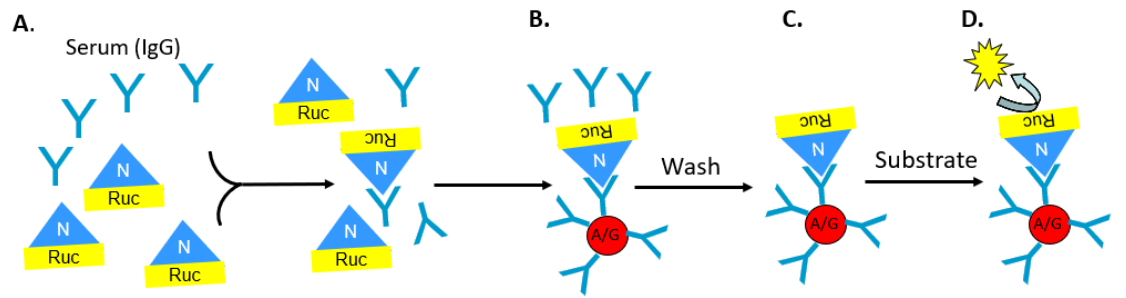
Figure 2. Schematic of the LIPS assay for detecting antibodies. LIPS is based on the fluid-phase capture of immunoglobulins. As shown for detecting antibodies against the SARS-CoV-2 nucleocapsid (N) protein. In the first step, ( A ) aliquots of the Ruc-SARS-CoV-2 N protein extract are incubated with serum samples and buffer. ( B ) The antibody complexes are then captured by protein A/G beads in